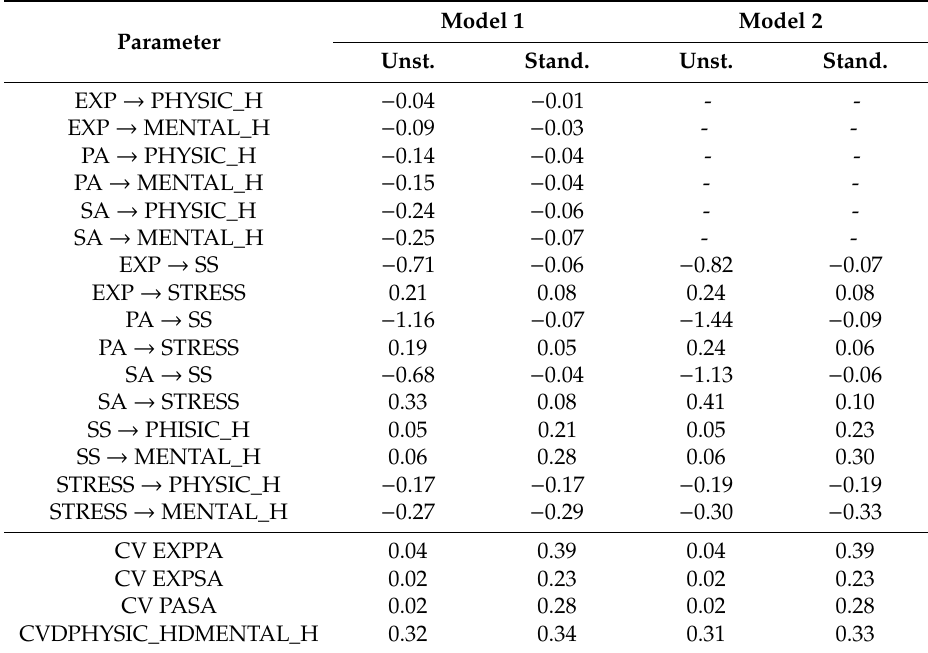
Table 2. Parameter estimates of direct e ff ects and covariances. Model 1 Model 2 Parameter Unst. Stand. Unst. Stand. EXP → PHYSIC_H − 0.04 − 0.09